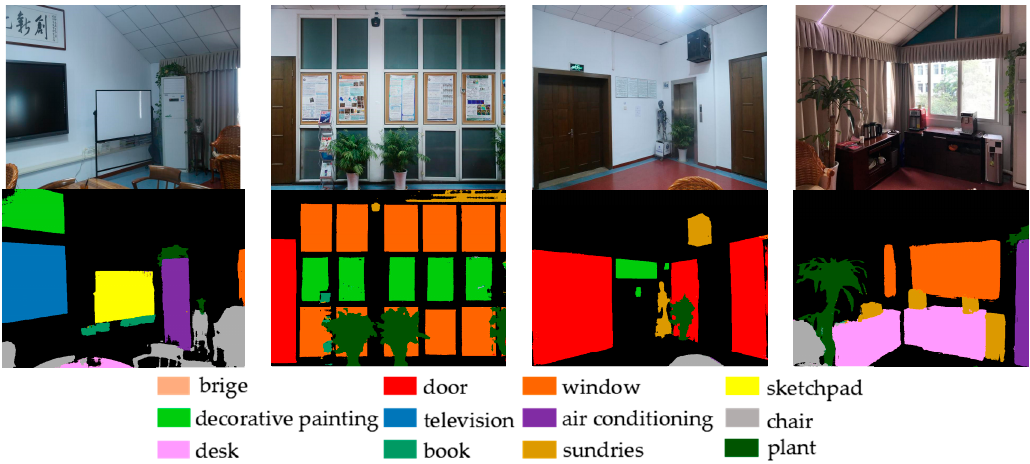
Figure 7. The semantically annotated models: ( a ) the semantically annotated model for the meeting room dataset; ( b ) the corresponding semantically annotated model for the lobby dataset.